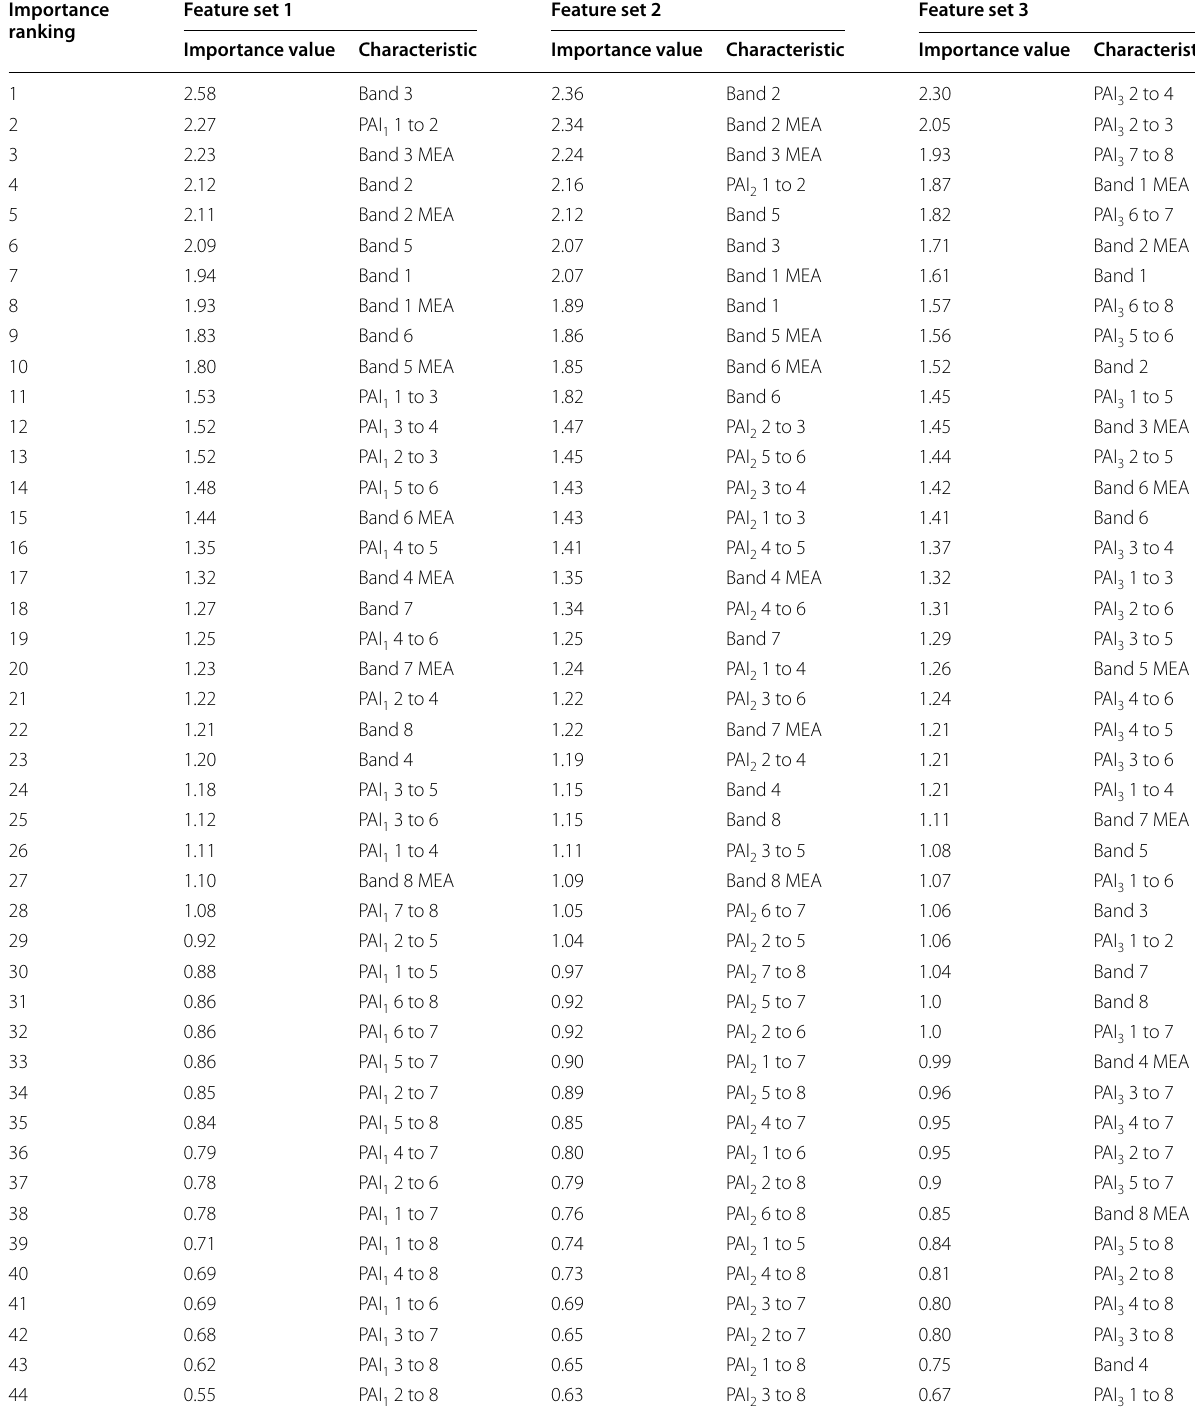
Table 4 Importance ranking of polygon area index features extracted by three algorithms in tree species classification based on feature sets and the results from